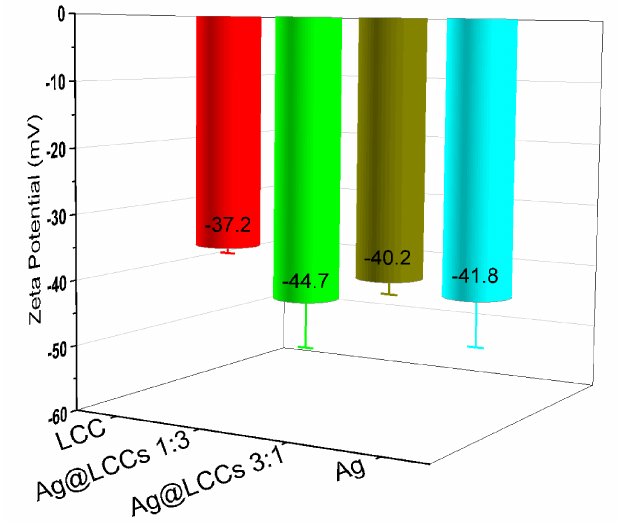
Figure 6. Zeta potential values measured for the considered